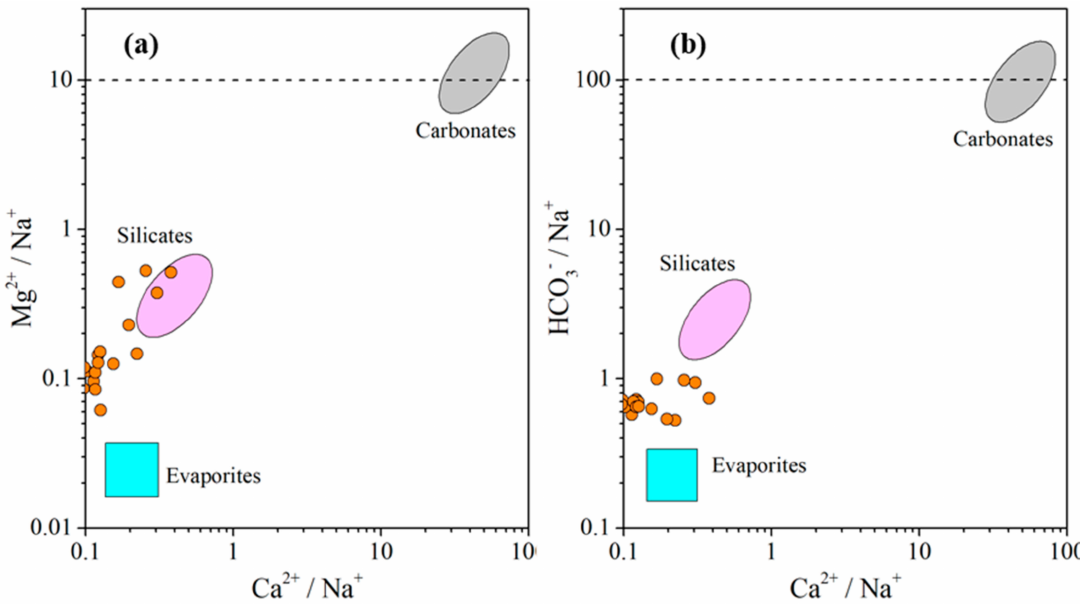
Figure 12. Scatter plots of ( a ) (Mg 2 + / Na + ) versus (Ca 2 + / Na + ), and ( b ) (HCO 3 − / Na + ) versus (Ca 2 + / Na +